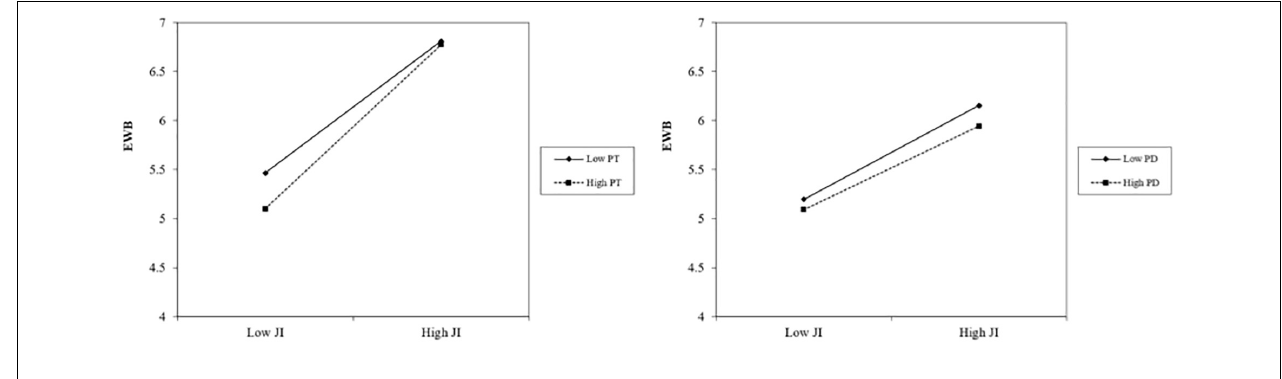
FIGURE 2 | Simple slope plots of